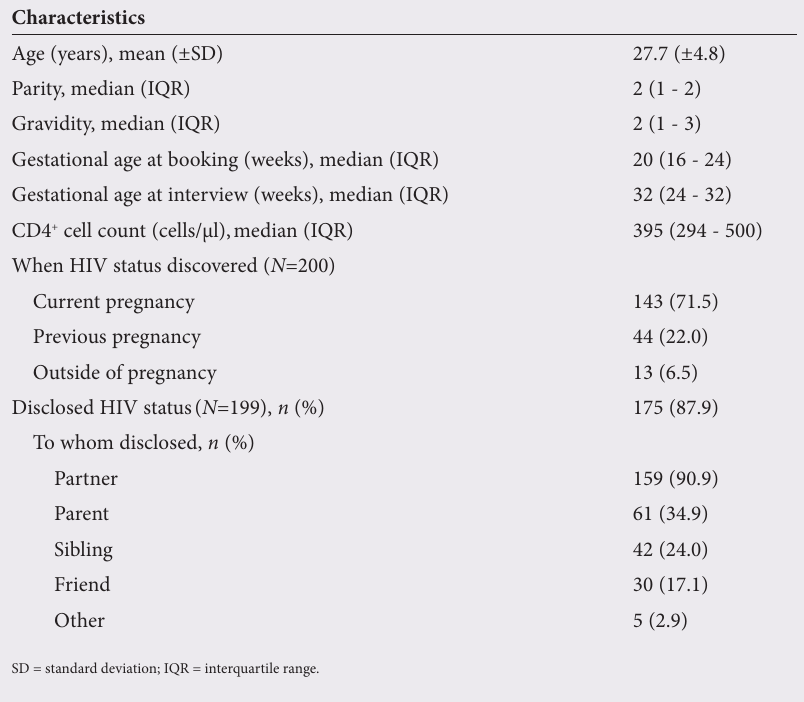
Table 1. Characteristics of pregnant women ( N